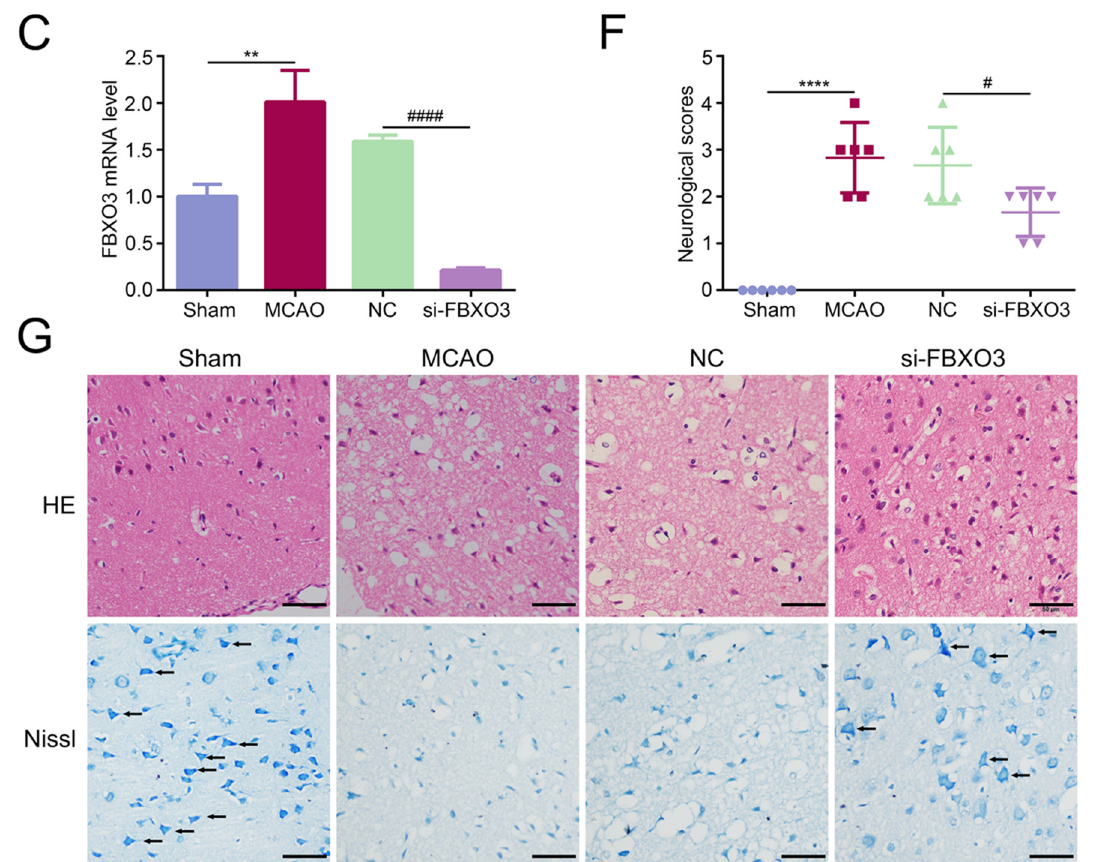
Figure 2. Interference of FBXO3 rescued the neurological outcomes after MCAO/R in vivo. ( A – C ) WB and qPCR analysis of FBXO3 in the peri ‐ infarcted cortex of MCAO/R rats with or without siRNA treatment and in sham rats. ( D ) Representative TTC (2,3,5 ‐ triphenyltetrazolium chloride) staining images of coronal sections of MCAO/R rats with or without siRNA treatment and sham rats. ( E ) Quantification of infarct volumes of coronal sections of MCAO/R rats with or without siRNA treatment and sham rats by ImageJ (total lesion volume/total brain volume × 100%). ( F ) Neurological deficit scores of MCAO/R rats with or without siRNA treatment and sham rats. ( G ) HE and Nissl staining (400 × , scale bar = 50 µ m) in the peri-infarcted cortex of MCAO/R rats with or without siRNA treatment and in sham rats. The arrows indicate representative Nissl bodies. Statistics for each group are expressed as mean ± SD ( n = 6). ** p < 0.01, **** p < 0.0001 (values in Sham group versus MCAO group), and # p < 0.05, #### p < 0.0001 (values in NC group versus si-FBXO3